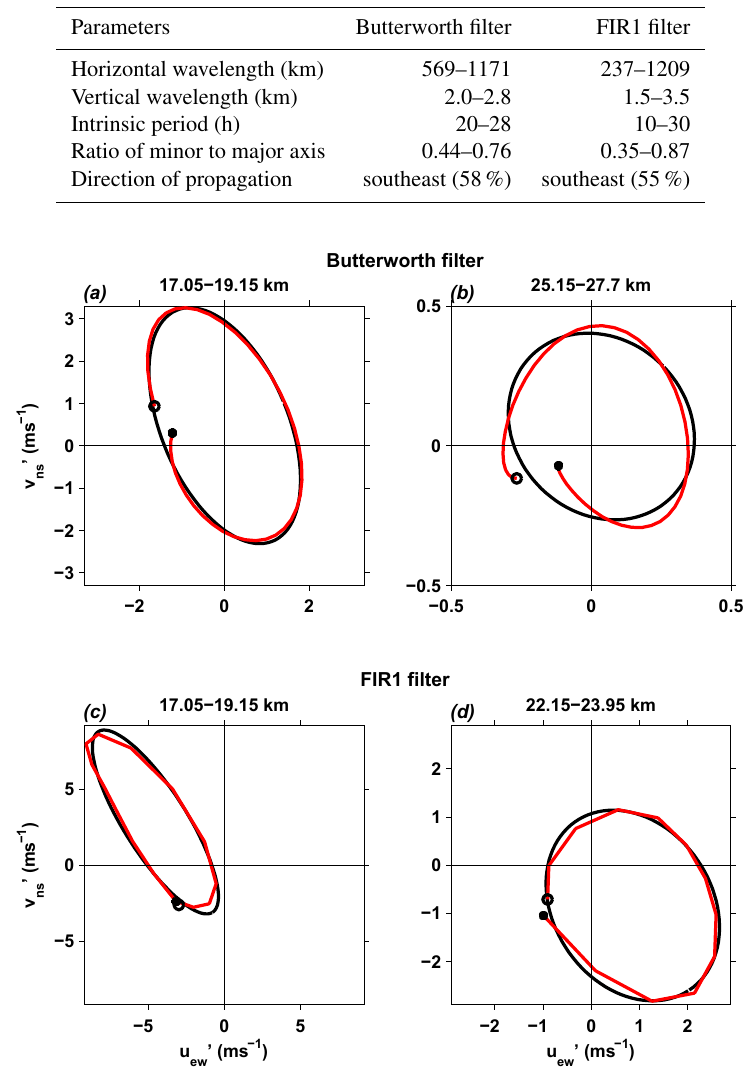
Figure 4. Hodographs of horizontal wind fluctuations (ms − 1 ) obtained using a Butterworth (a, b) and FIR1 (c, d) filters. An open circle and a solid circle in each hodograph indicate the lowest and highest altitudes, respectively. The thin curves represent the elliptical fits.